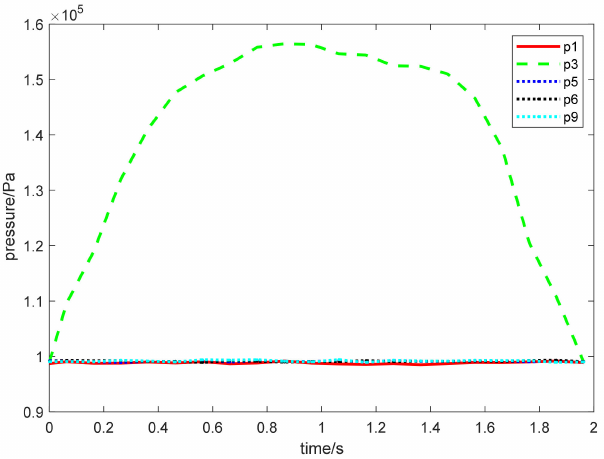
Figure 28. Pressure data measured by pressure sensors 1, 3, 5, 6, 9.